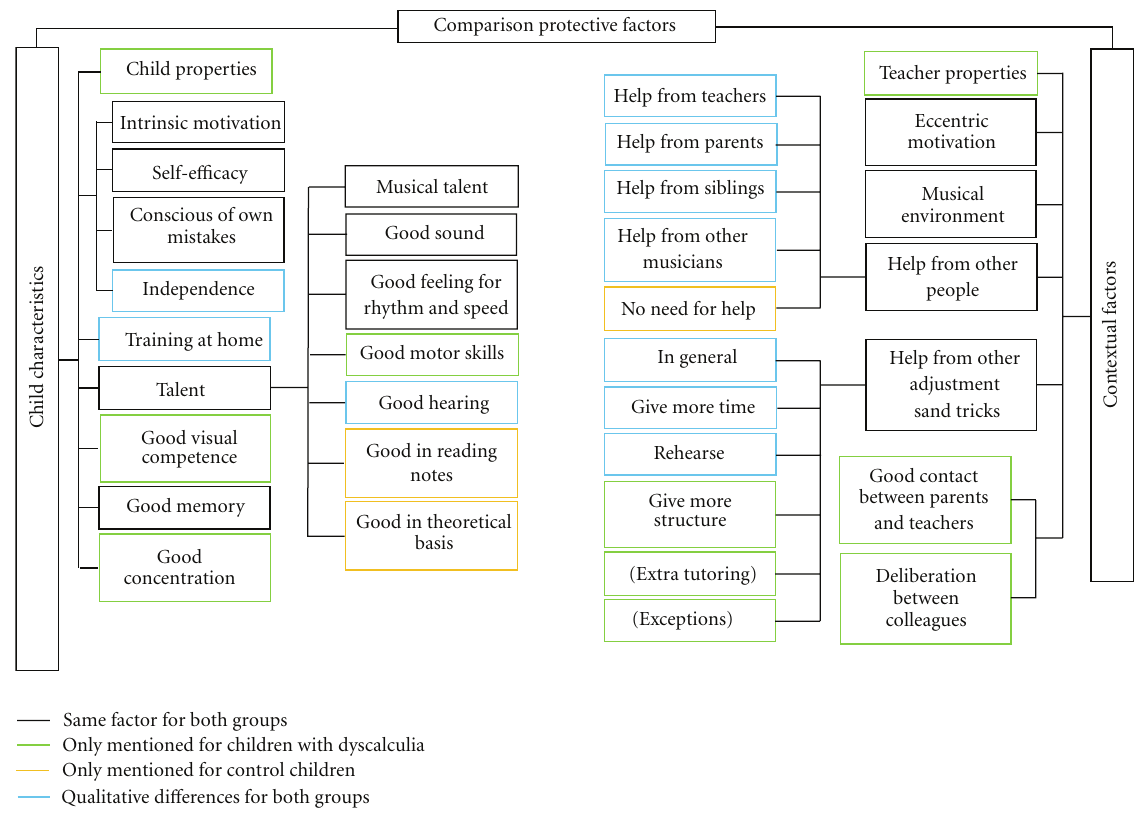
Figure 1: What makes a child successful in